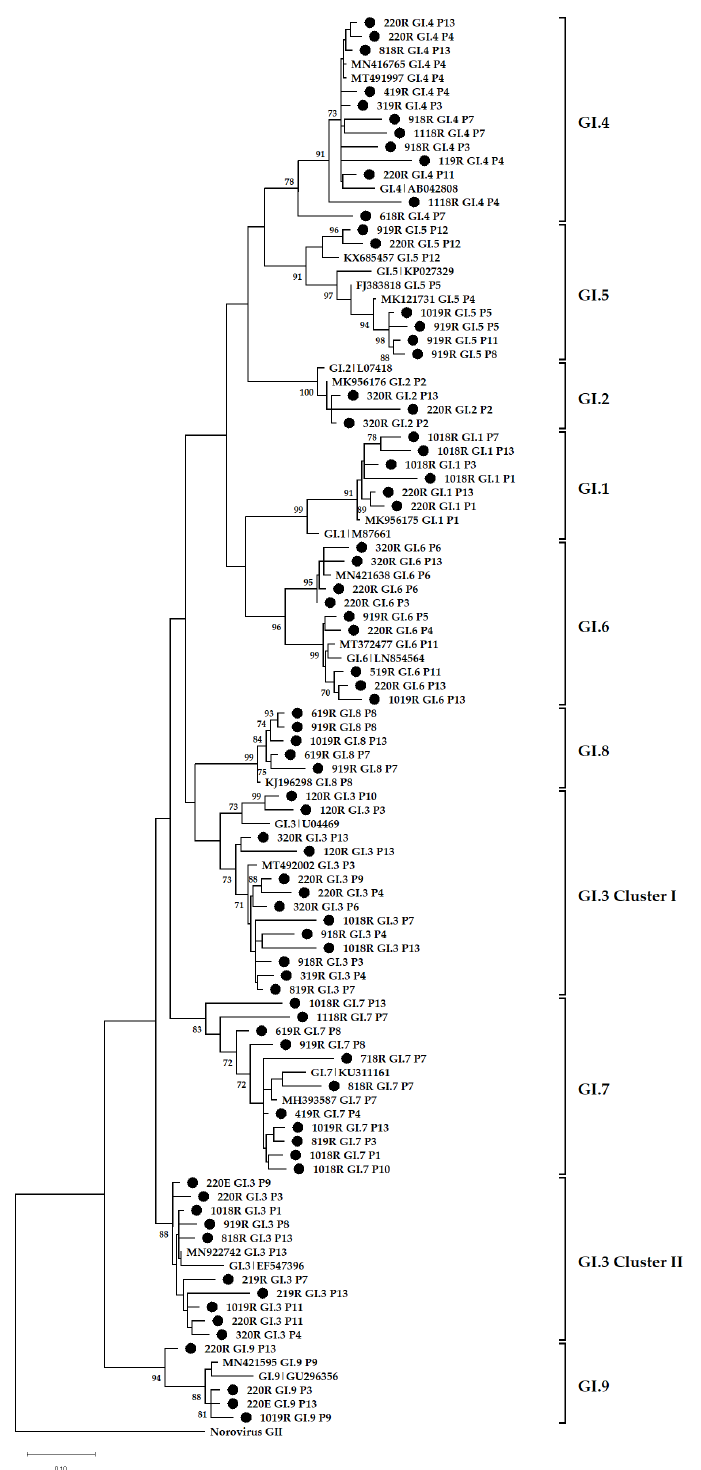
Figure 5. Phylogenetic analysis of the 314 bp at 5 (cid:48) -end of norovirus GI ORF2. Representative sequences identified in this study are indicated by black circles ( • ). All strain sequence names contain specific ID, genotype and P-type. Reference strains and the most closely related strains were downloaded from GenBank. The Maximum Likelihood phylogenetic trees were constructed using MEGA X software [46] and 1000 bootstrap replicates based on the Kimura 2-parameter model. The sequences were labelled according to month and year of detection, wastewater type, P-type and genotype, e.g., 618RGI.2[P2] = GI.2[P2] virus detected in raw sewage collected in June